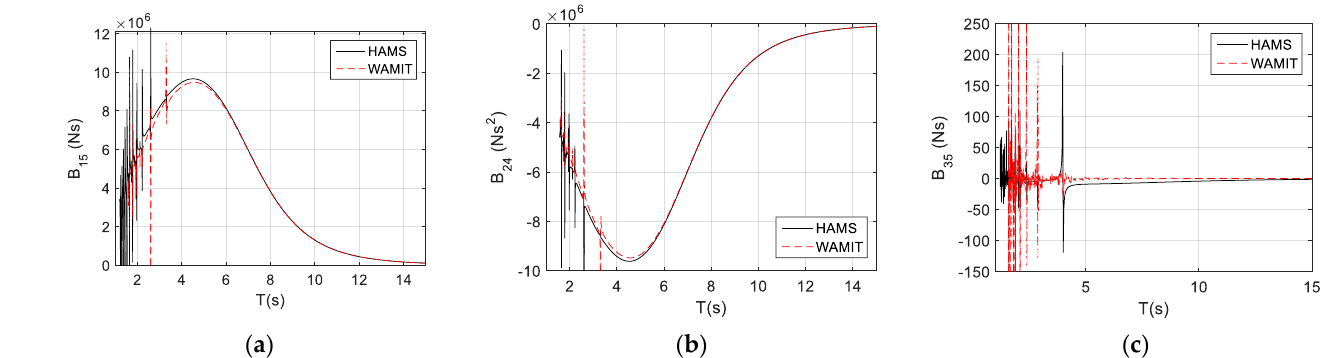
Figure 4. The conventional radiation-damping coefficients of the TALOS structure. ( a ) ; (𝐛) 𝐵 ; (𝐜) 𝐵 ; (𝐝) 𝐵 ; ( e ) 𝐵 ; (𝐟) 𝐵 𝐵 11 22 33 44 55 66 for motions of surge, sway, heave, roll, pitch, and yaw, respectively.